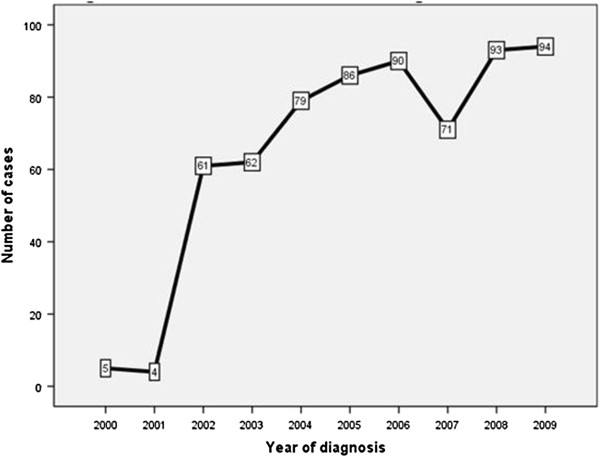
Year wise trends of HCC cases during 1999 till 2009.